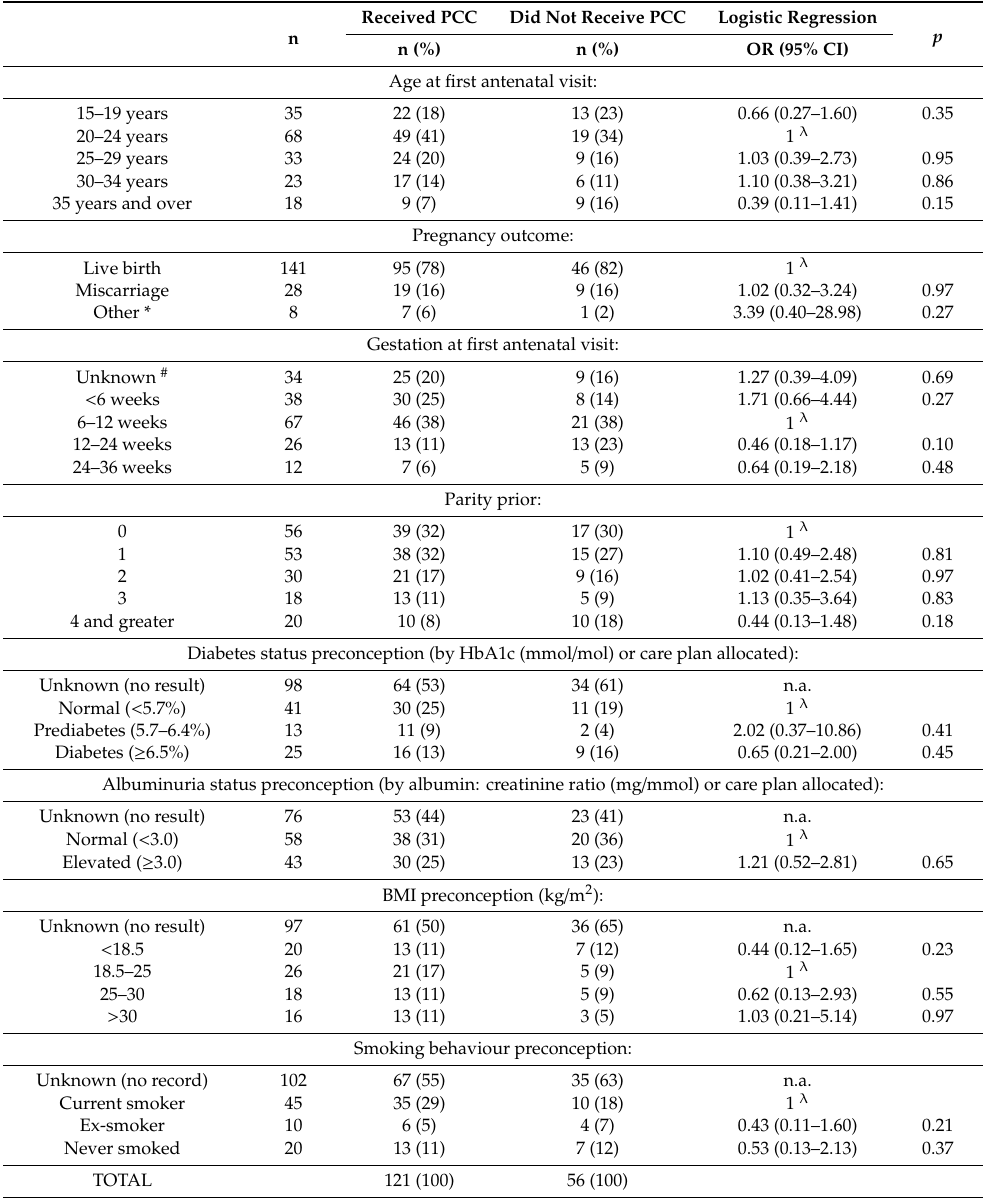
Table 1. Characteristics of confirmed pregnancies, by preconception care (PCC) group (n = 177).